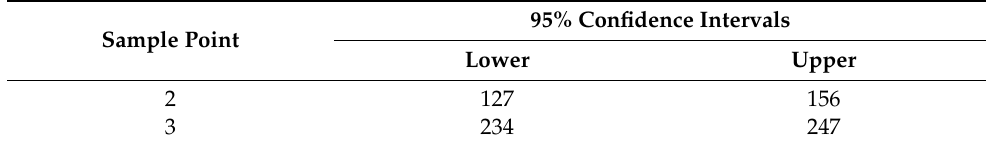
Figure 3. Histograms for the optimal Sample Points 2 and 3 as determined by Monte Carlo simulation. Table 3. The 95% confidence intervals of Sample Points 2 and